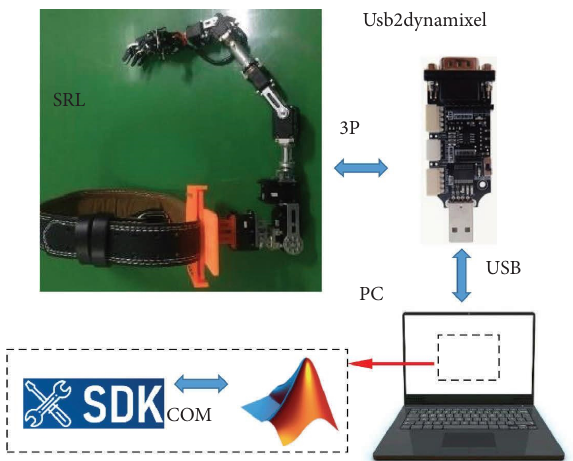
Figure 9: Schematic diagram of the SRL data collection.